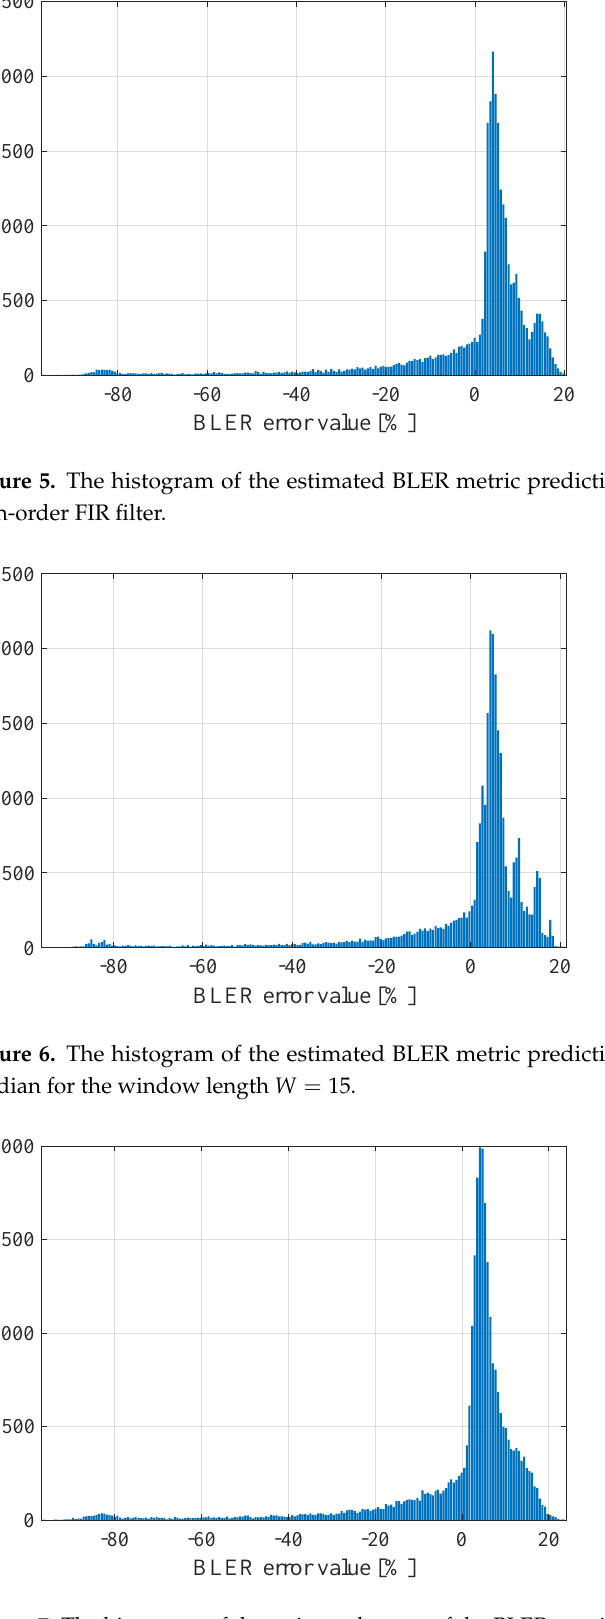
Figure 7. The histogram of the estimated errors of the BLER metric prediction for prediction with the use of separate linear models for each parameter for the window length W =